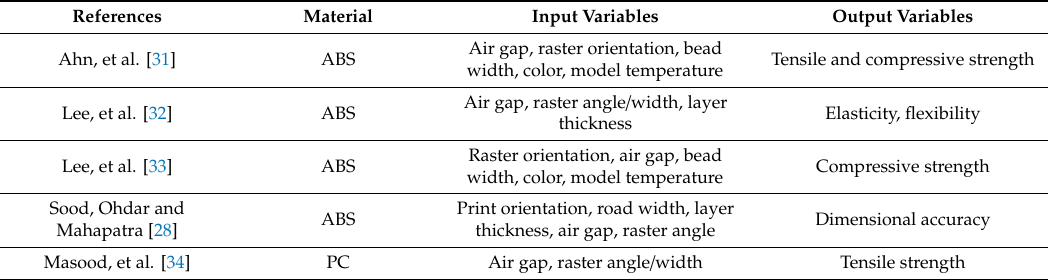
Table 1. Summary of additive manufacturing studies for fused filament fabrication (FFF) based on the design of experiment